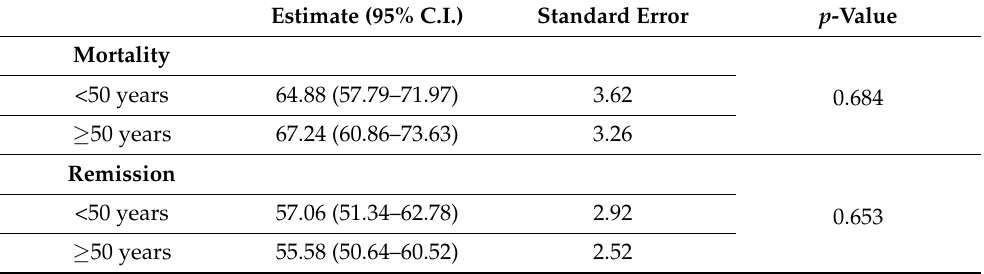
Table 6. Mortality and remission of CRC among the two age